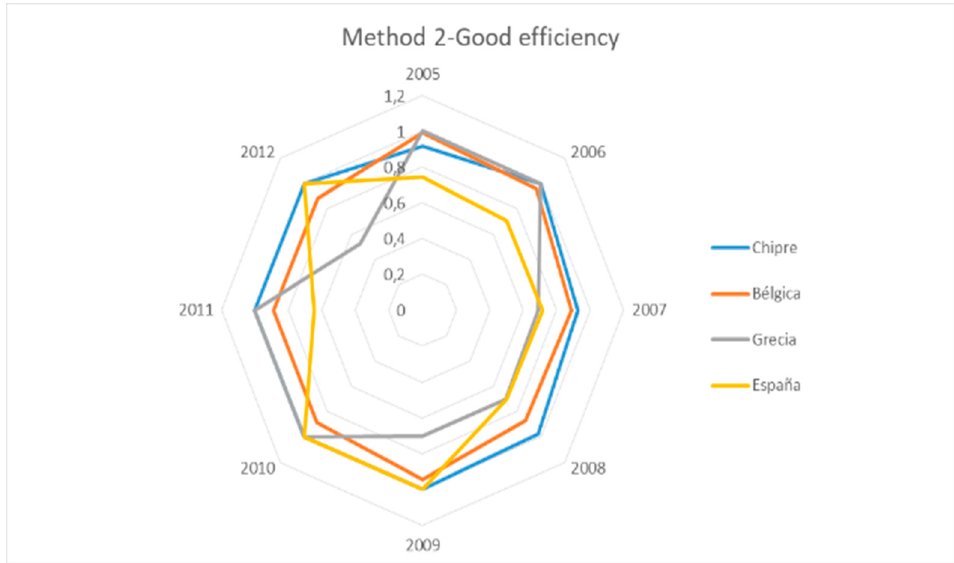
Figure 7. Variation in environmental efficiency in the years 2005–2012 with the DEA Method 1 and for Method 2 for the 14 countries in the category “Good environmental efficiency”. Source: self